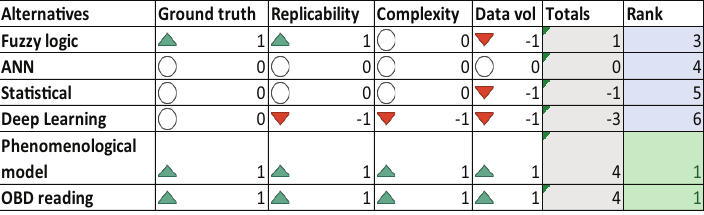
Figure 6. Decision matrix—Emissions.